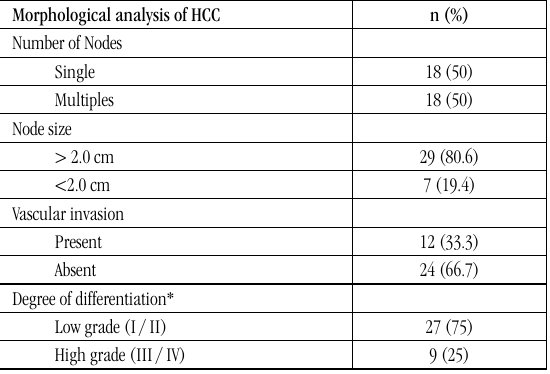
TABLE 3 - Correlation between the immunohistochemical score of Shh protein in the cirrhotic and tumor parenchyma in HCC from liver transplantation performed at HC-UFMG in the period between 2003 and 2015